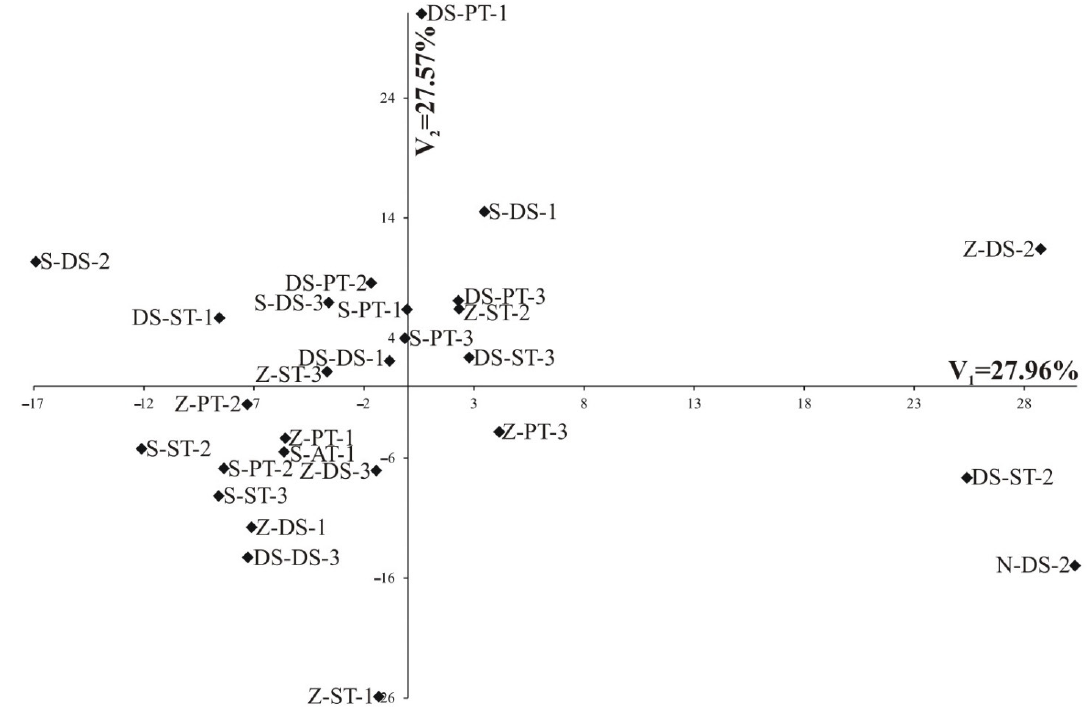
Figure 4. Distribution of the spring wheat treatments in the two first canonical variates at the 3rd term (cover crop: Z—zero, S—skimming, DS—direct sowing, ST—simplified tillage, PT—spring ploughing; years: 1—2011, 2—2012, 3—2013).